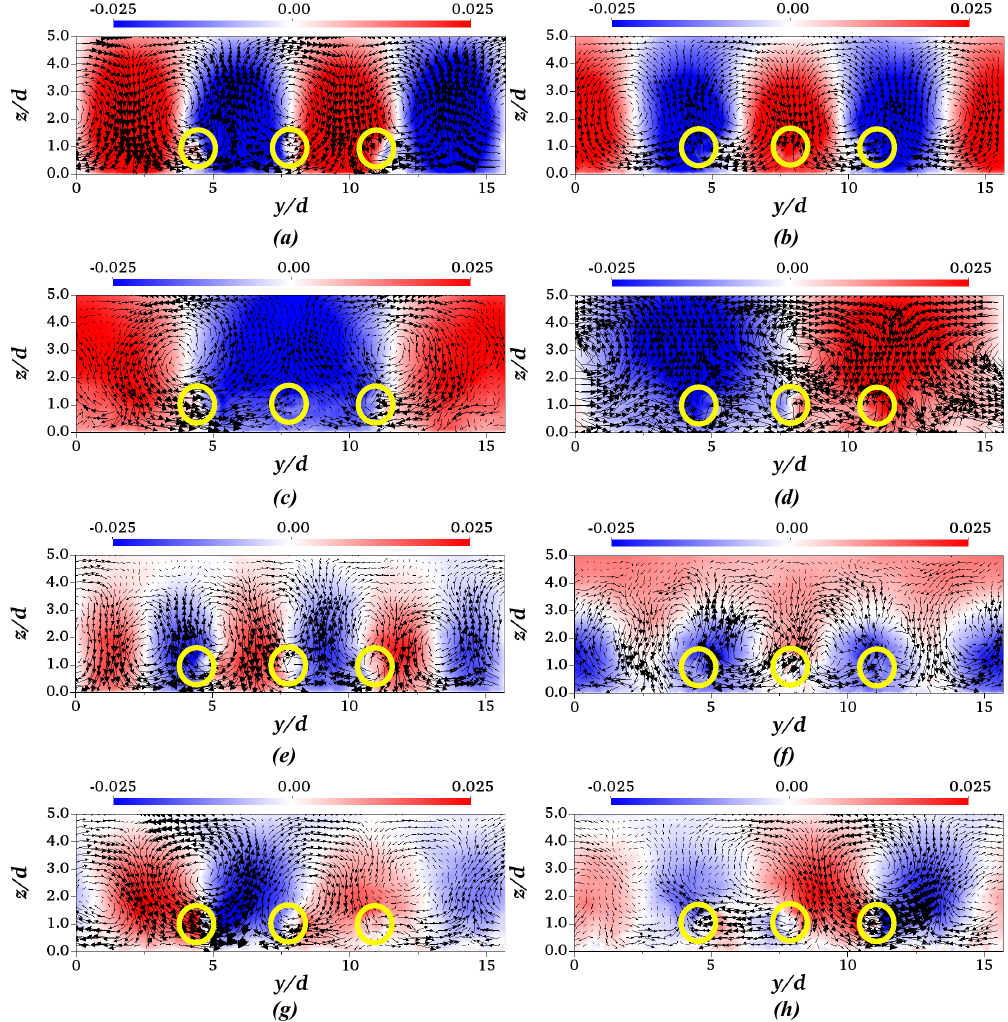
Figure 5. Normalized POD mode for ( a ) m = 0, ( b ) m = 1, ( c ) m = 2, ( d ) m = 3, ( e ) m = 4, ( f ) m = 5, ( g ) m = 6, ( h ) m = 7 for finite-sized wind turbine array. Red-blue contours indicate the √ λ normalized streamwise velocity modes, ϕ u k / U ∞ overlayed with in-plane spanwise and k